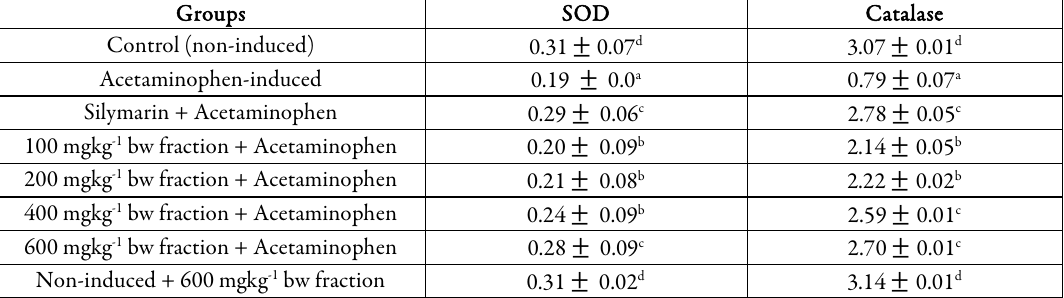
Table 6. Specific activities of superoxide dismutase (SOD) and catalase (CAT) (nmolmin -1 mg protein -1 ) in liver of the rats